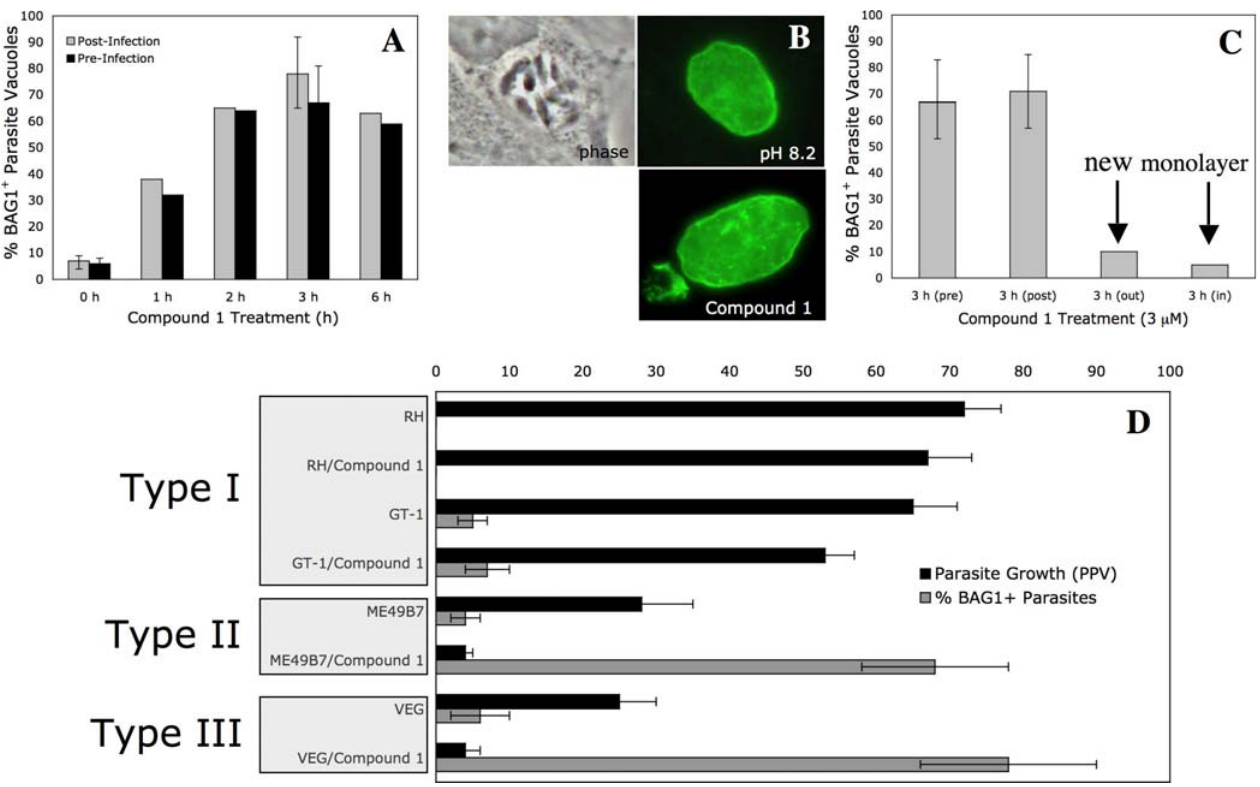
Figure 1. Compound 1–Induced Parasite Growth Inhibition and BAG1 Expression (A) Parasites allowed to invade an HFF monolayer, and then treated 1, 2, 3, or 6 h with 3 l M Compound 1, express maximal levels of BAG1 after 3-h treatment (light bars). Similar BAG1 expression was observed with host monolayers that were pretreated with Compound 1 (dark bars). (B) Phase image of pH-induced vacuole is shown at 72 h postinfection. Following immunostaining with dolichos lectin, note the phenotypic similarities between cyst wall formation in alkaline media and that induced by 3 l M Compound 1. (C) Treatment of extracellular (out) or intracellular parasites (in) with 3 l M Compound 1 for 3 h was unable to induce BAG1 expression following infection of untreated HFF monolayers (72 h postinfection). Compare percent BAG1 induction with VEG parasites that remained in a pre- or post-treated culture for 72 h. (D) Type I RH and GT-1 tachyzoites inoculated into Compound 1 (3 l M for 3 h)–pretreated HFF cells displayed little or no BAG1 expression (light bars), while in type III VEG or type II ME49B7 cultures, 68% to 75% of parasites express BAG1. Note that parasite growth is dramatically affected in VEG and ME49B7 cultures but not in RH or GT-1 parasites (black bars). The x -axis in this graph is used to plot both percent BAG1 þ and average vacuole size. DOI: